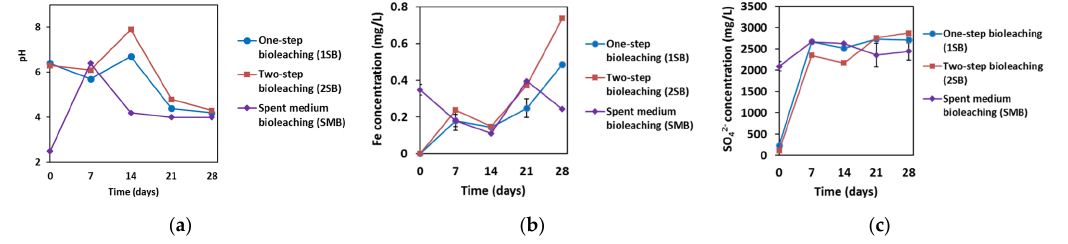
Figure A1. The evolution of pH ( a ), Fe ( b ) and sulphate (SO 42 − ) ( c ) concentrations during the bioleaching of the Neves Corvo waste rock (NC_01) by the Thioclava consortium. Values are the average of duplicate flasks ± standard deviations.